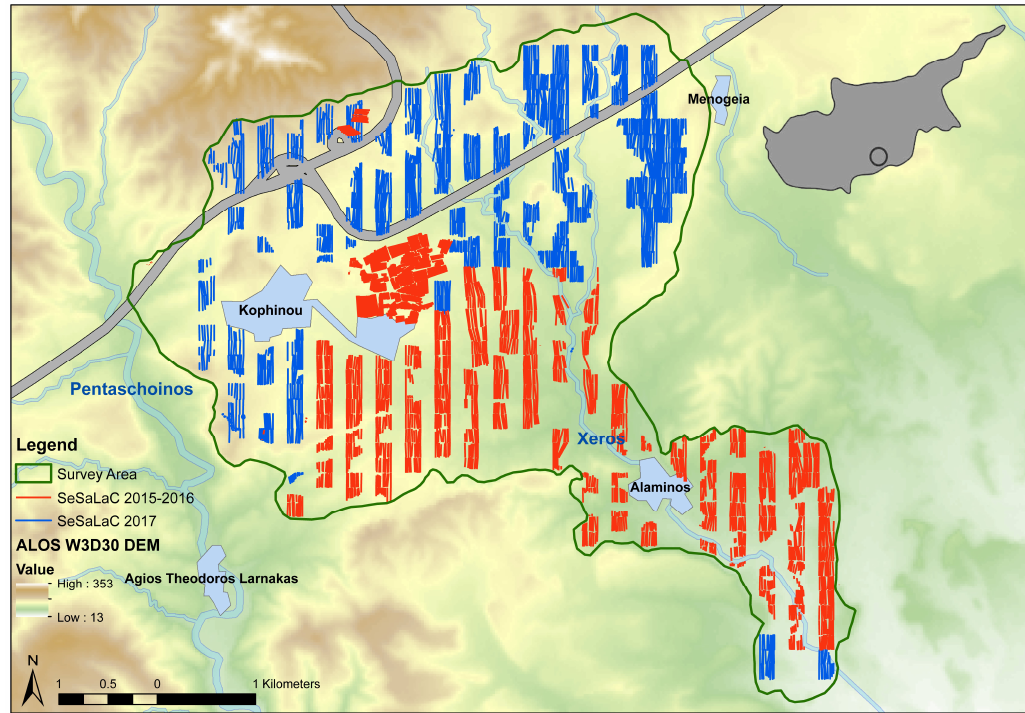
Figure 1. SeSaLaC surface survey area with transects (zones of squares: 150 × 150 m) investigated in 2015–2016 and 2017. ALOS DEM are in metres. Digital data courtesy of the Geological Survey Department, Republic of Cyprus (Map by Charalambos